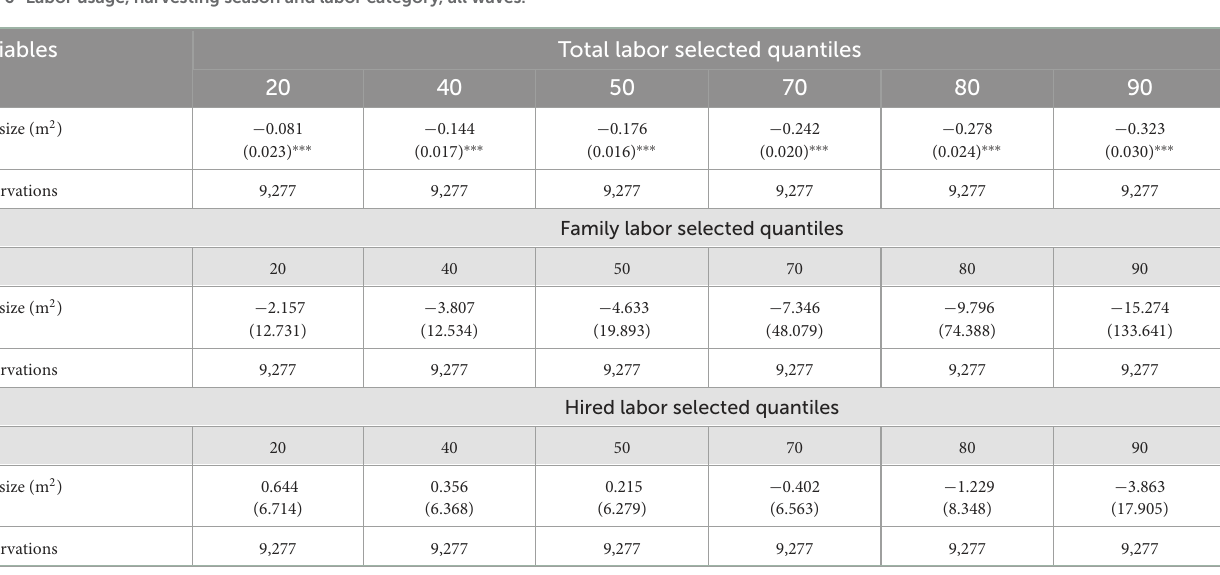
TABLE 6 Labor usage, harvesting season and labor category, all